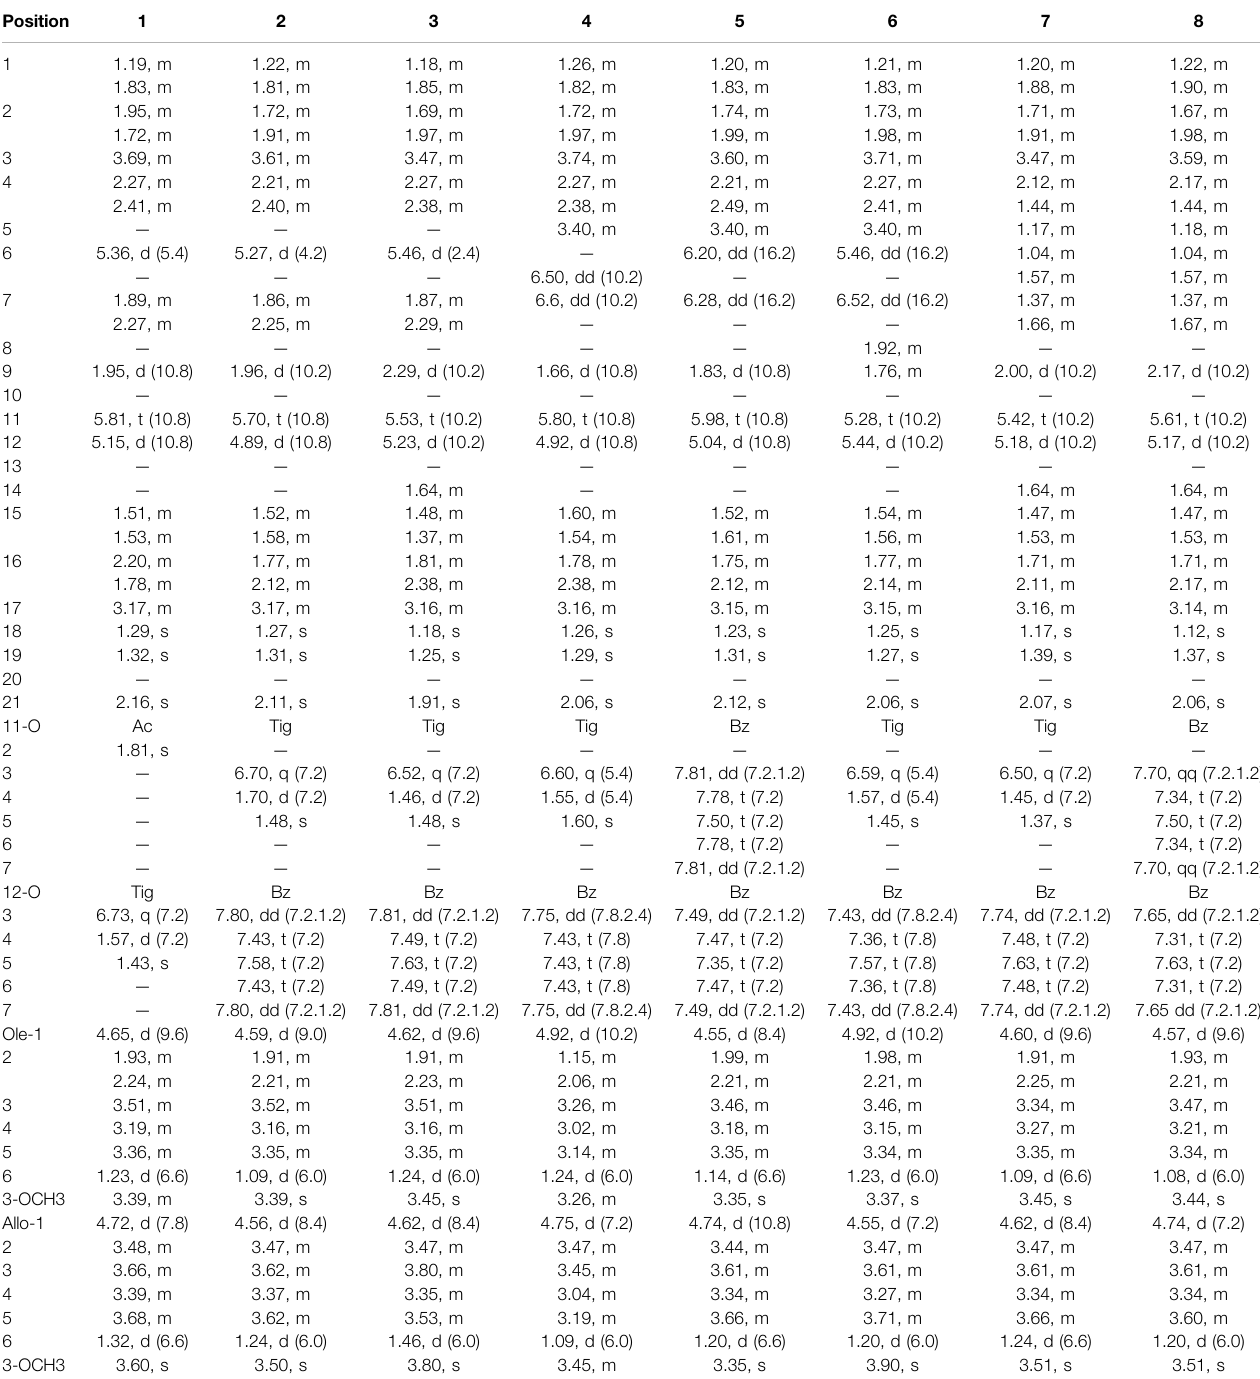
TABLE 1 | 1 H NMR spectroscopic data (600 MHz, 1 in MeOD and 2 – 8 in DMSO) for compounds 1 – 8 ( δ H in ppm, J in